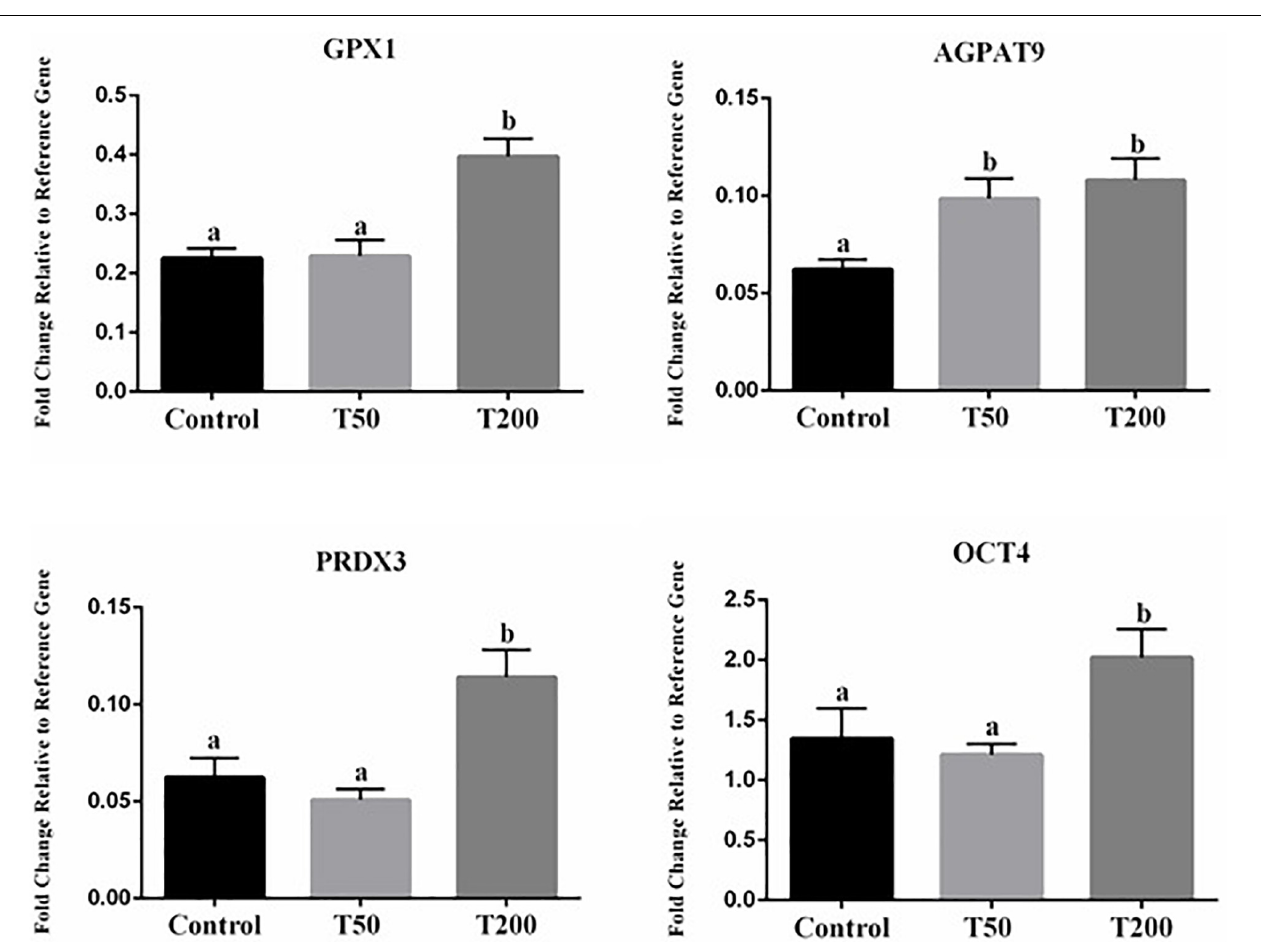
FIGURE 6 | Effect of TUDCA concentrations on differential gene expression in embryo during IVM. Data represent the fold change in level of expression relative to reference gene. Results are represented as least-squares means ± SEM of five replicates using 218–224 COCs/treatment. Different letters in each bar represent significant differences ( P ≤ 0.06). Control, 0 µ M TUDCA; T50, 50 µ M TUDCA; T200, 200 µ M